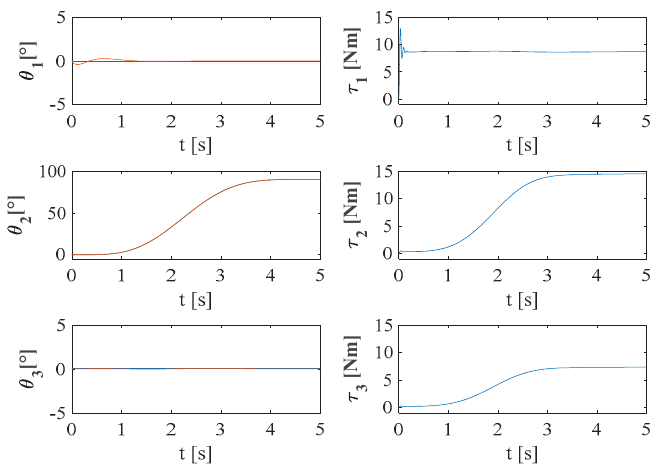
Figure 10. Response for a flexion movement with the GPI controller, given by Equation (13), considering the weight of the patient’s arm.